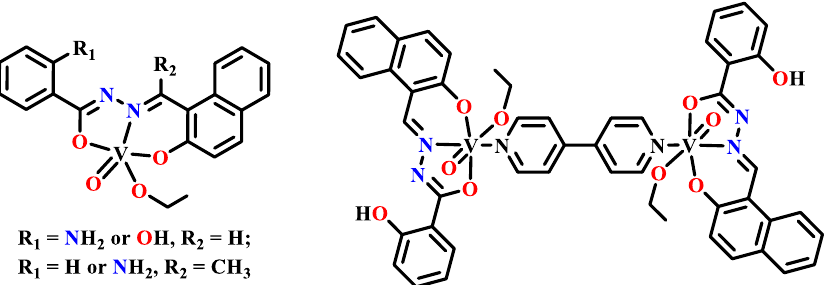
Figure 59. Some vanadium(V) complexes of naphthylhydrazone with an o -hydroxybenzamide side chain, reported by Rupam Dinda’s group.